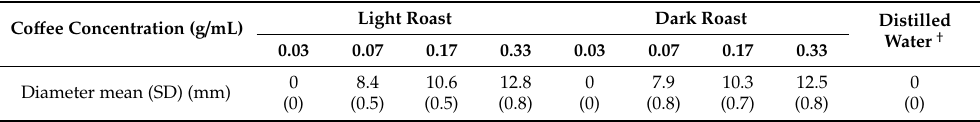
Table 1. Inhibition zones of the light and dark-roast co ff ee extracts against Porphyromonas gingivalis (ATCC 33277) at 16